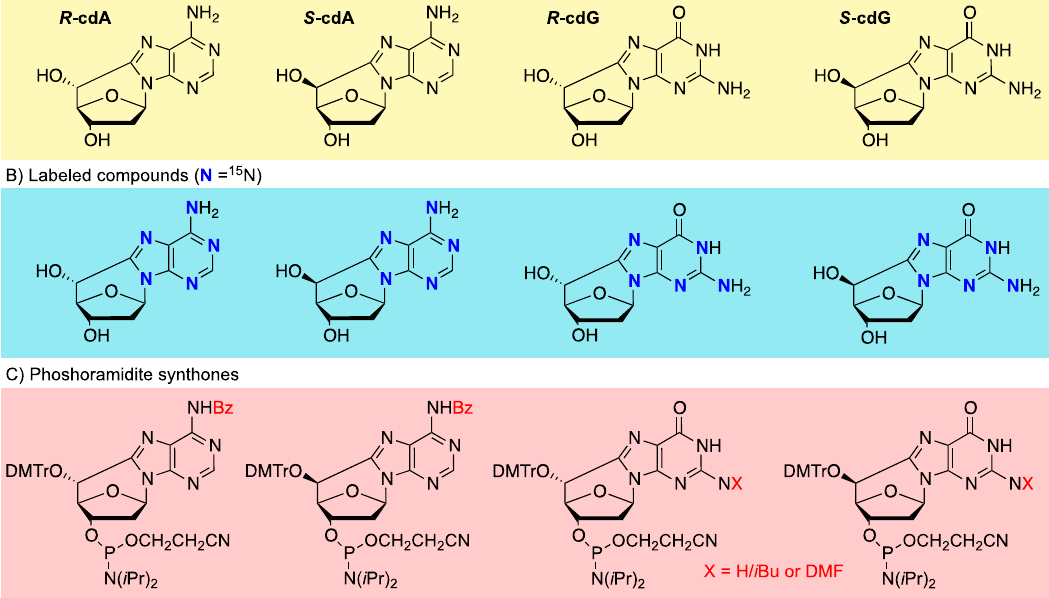
Figure 2. Libraries of purine 5 ′ ,8-cyclo-2 ′ -deoxynucleosides (cPu).